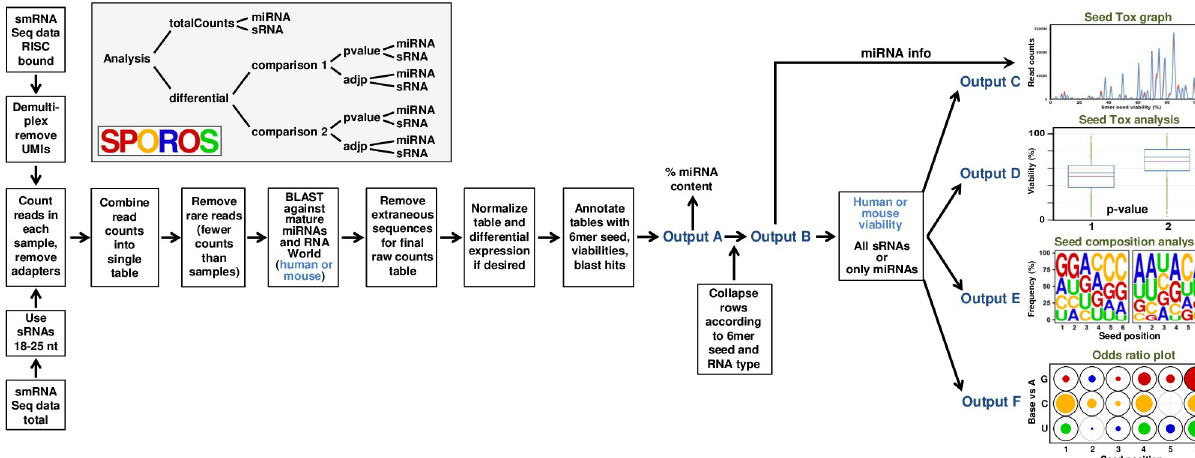
Fig 1. SPOROS workflow developed to analyze seed toxicity of smRNA Seq data. From left to right: smRNA seq data, either total or RISC-bound, are trimmed and cleaned and then compiled into a counts table. Rare reads are removed (fewer counts than the number of samples) and the remaining reads are BLASTed against all mature miRNAs or RNA world data sets of all small RNAs (either human or mouse). Reads that hit artificial sequences in the RNA world datasets are again removed. The remaining raw counts table can be normalized to 1 million reads per sample or column or used for differential expression analysis. RawCounts, normCounts, or differential tables are annotated with 6mer seed, 6mer seed viability, miRNA, RNA world to generate Output A tables. At this point the miRNA content (%) can be determined. Reads of this Output A file are collapsed according to 6mer seed and RNA type resulting in Output B. At this point all short RNAs can be analyzed (sRNA) or just the miRNA fraction. Output B is fed into four scripts generating four output files: C: A Seed Tox graph that depicts all miRNAs as peaks according to their seed viability; D: Average predicted 6mer seed toxicity of all reads in a samples depicted as box and whisker plot; E: Weblogo plot showing the average seed composition in positions 1–6 of the 6mer seed in each sample; F: The result of a multinomial mixed model odds ratio analysis allowing to compare both different 6mer seeds as well as differences in each position of different seeds. The hierarchy of folders and subfolders generated by SPOROS is shown in a grey box.